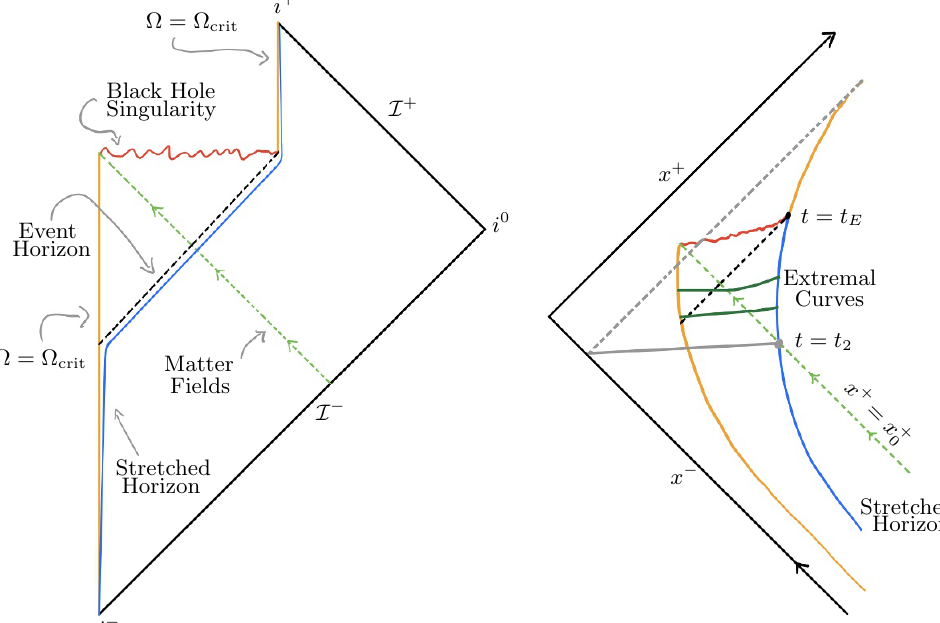
Figure 4 . ( Left ) Cartoon of the Penrose diagram of the life cycle of an evaporating black hole formed by collapse. ( Right ) Depicts Kruskal diagram of the scenario illustrated in the left (cid:12)gure. The color coding